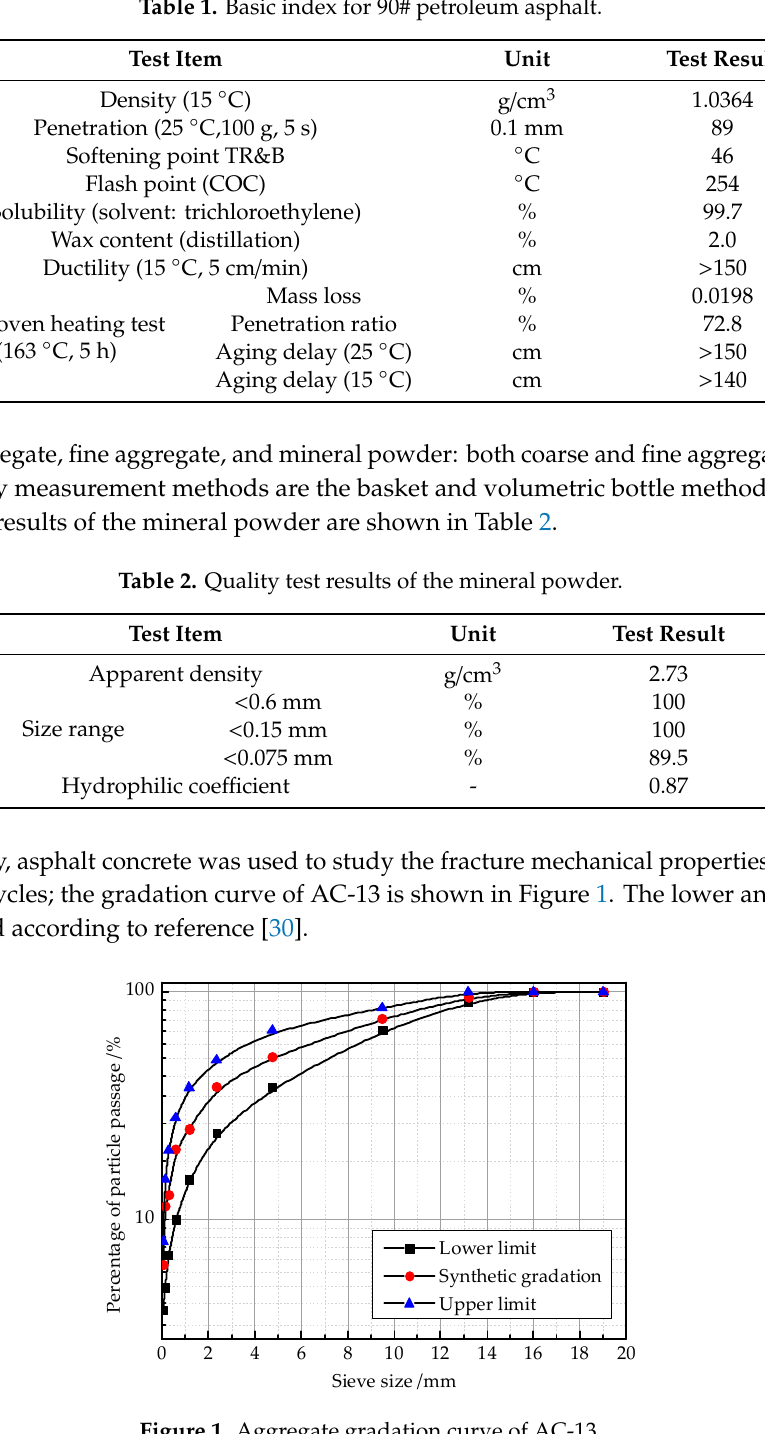
Figure 1. Aggregate gradation curve of AC-13.